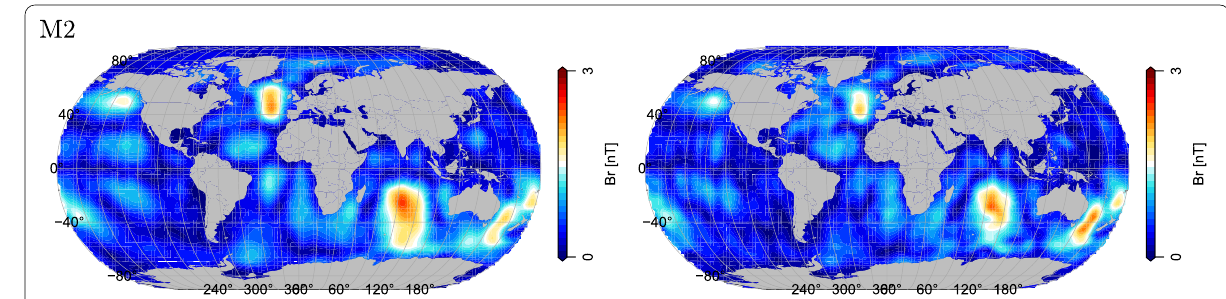
Fig. 3 Tidal radial magnetic field (M2). Left column: results from CIY4 (Sabaka et al. 2018), i.e., 4 years of Swarm data. Right column: results from CM5 (Sabaka et al. 2015), i.e., mostly 12 years of CHAMP data. All fields are represented at the satellite height of 430 km above sea